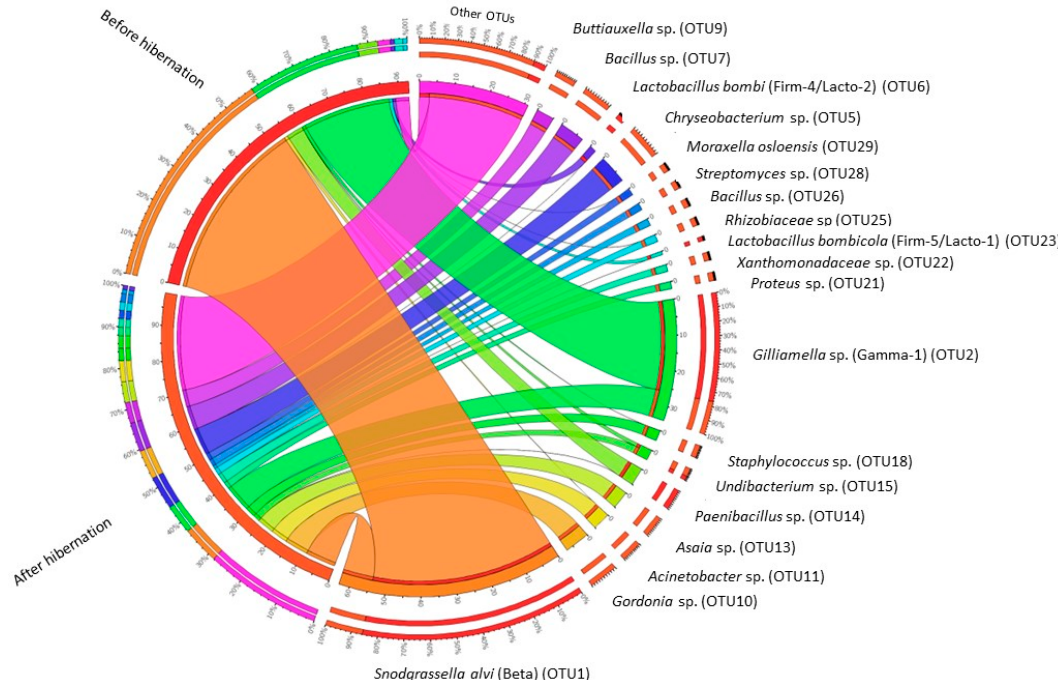
Figure 4. Circular visualization of the occurrence and abundance of gut bacterial operational taxonomic units (OTUs) in bumblebee queens ( Bombus terrestris ) before ( n = 15) and after hibernation ( n =